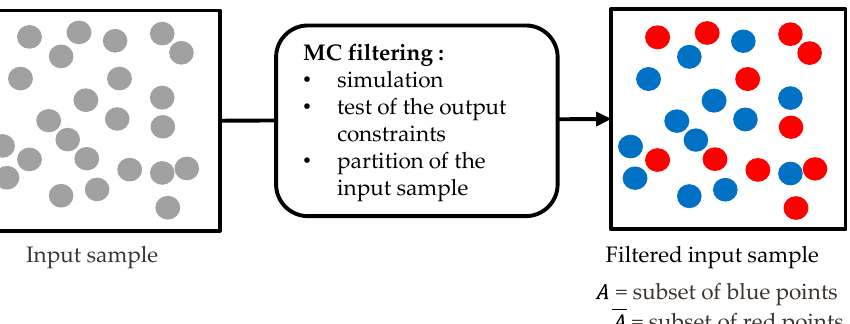
Figure 4. Monte Carlo filtering: the model is applied to the input sample and the acceptability criteron is checked. Then, the input sample is partitioned into the acceptable subset A (blue points, whose outputs meet the acceptability criterion), and the non acceptable subset A (red points, whose outputs do not meet the acceptability criterion).